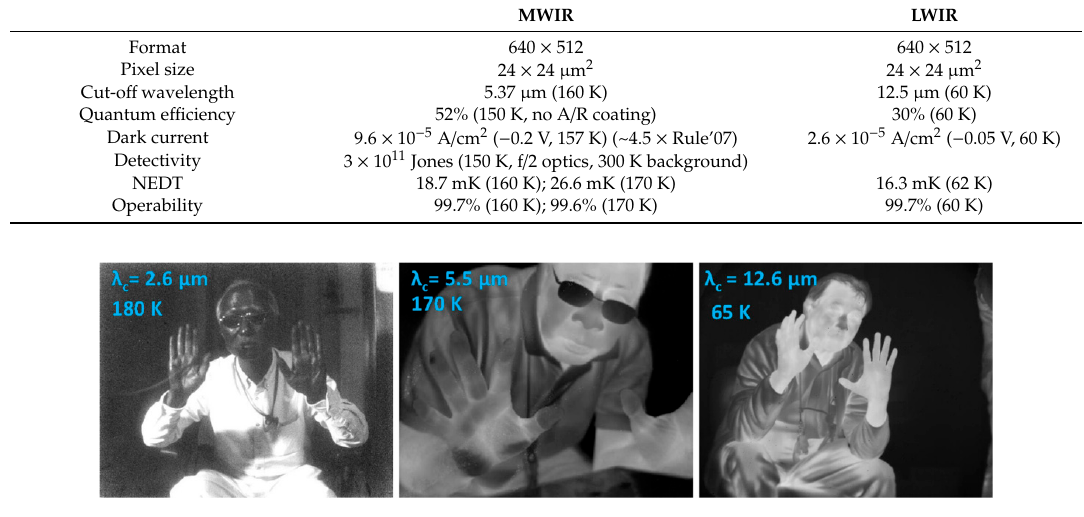
Figure 74. e-SWIR, MIWR, and LWIR images registered by Sb-based FPA. The e-SWIR FPA is based on a bulk InGaAsSb, T2SLs InAs/InAsSb active layer was used for the MWIR and LWIR (after [107]).